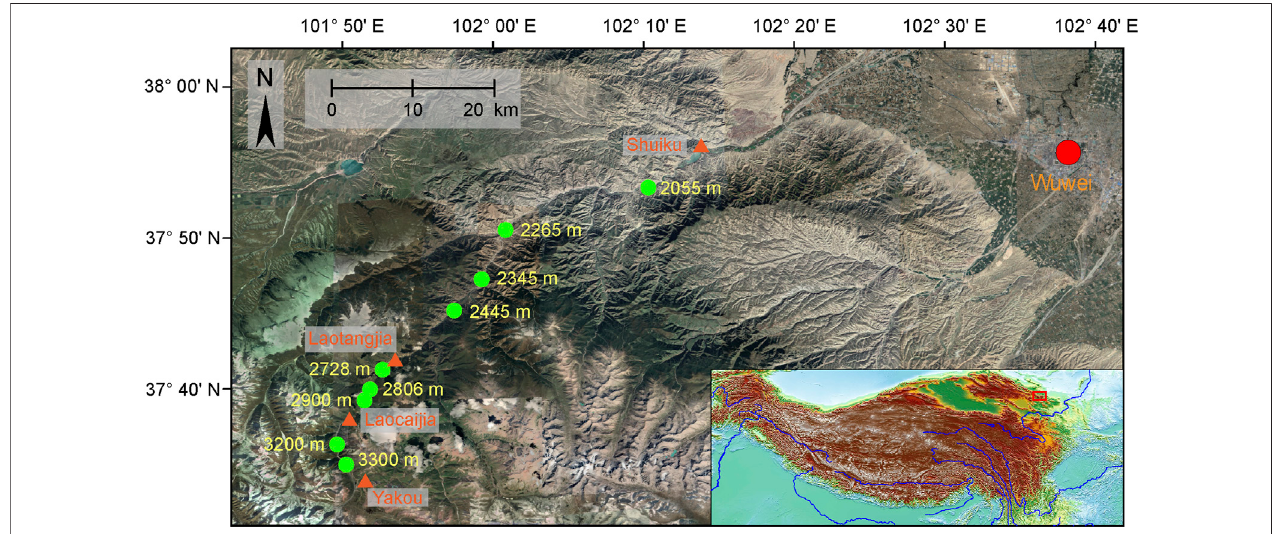
FIGURE1| TopographicmapoftheQilianShanandsamplingsites(greendots).Theredtrianglesindicatethelocationsofthefourmeteorologicalmeters.Revised from Gao et al. (2021). The base map is from Google Image.